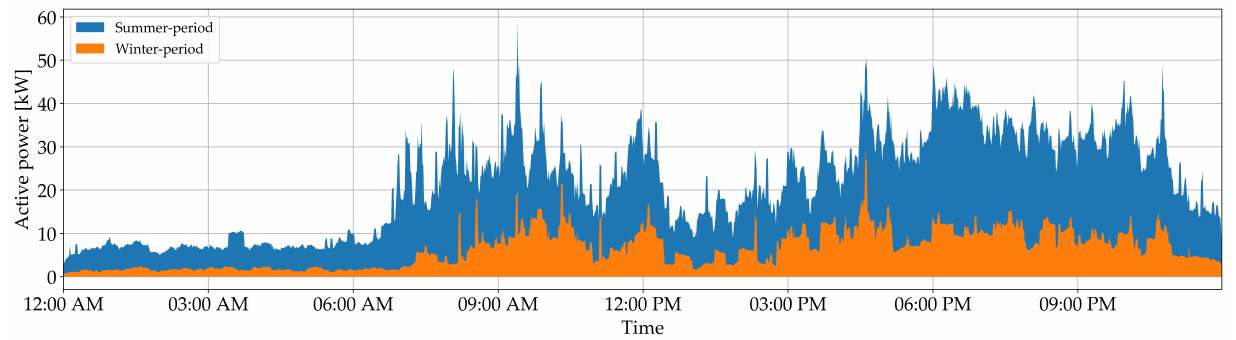
Figure 10. Winter-period and summer-period consumption profiles of the test